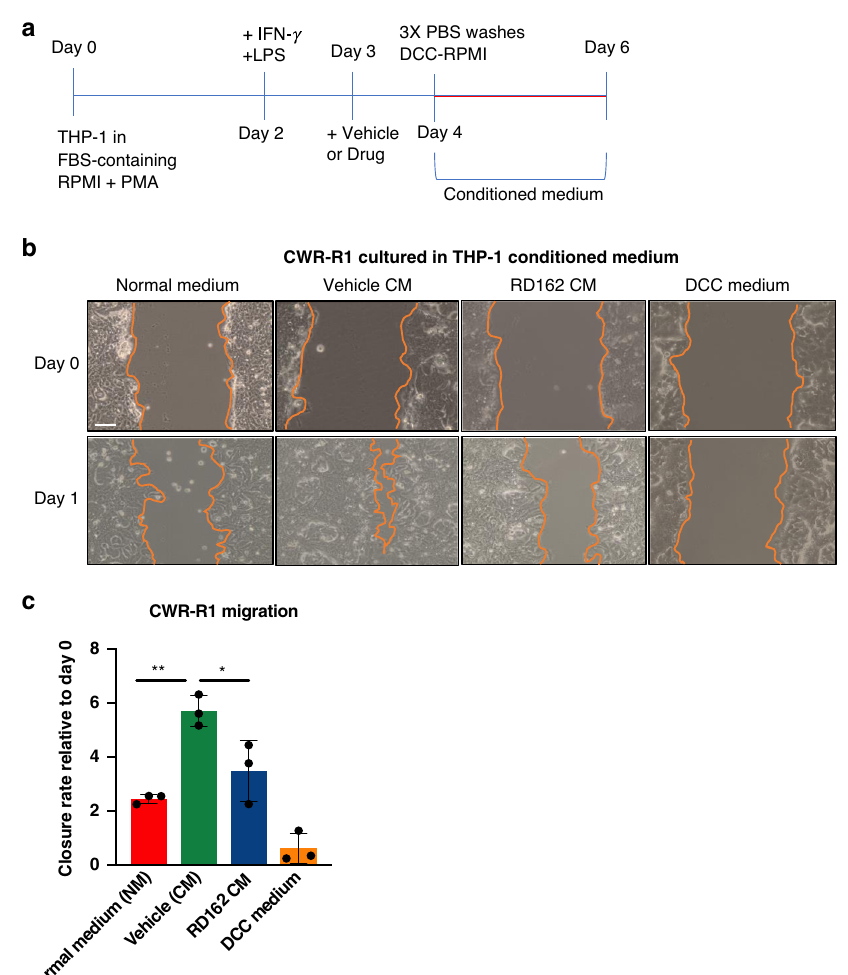
Fig. 3 AR signalling in THP-1 cells affects PCa cell line migration. a Work fl ow showing the procedure of THP-1 cell differentiation into macrophage-like cells and generation of CM. THP-1 cells were stimulated with PMA (Day 0), IFN- γ and LPS (Day 2) and exposed to Vehicle or Drug on Day 3. After 24h of stimulation, cells were carefully washed and replenished with fresh medium. Medium was collected as ‘ CM ’ after 48h. b Scratch assay of CWR-R1 human PCa cells cultured in normal medium (NM) alone or in combination with CM of THP-1 cells stimulated with vehicle or RD162 at base line (0h) and after 24h. Charcoal-stripped (DCC) medium was used as a control. Representative of three different images per condition. Scale bar = 200 µ m. c Quanti fi cation of three independent scratch assays. Datapoints show mean value of three technical replicates in each experiment. CWR-R1 cell migration is assessed through closure of the scratch after 24h relative to day 0. Error bars represent the s.e.m.. *: p = 0.02 and **: p = 0.002. p -Values were calculated from means of three biological replicates using a One-way Anova test with a cutoff for signi fi cance of 0.05. Source data are provided as a source data